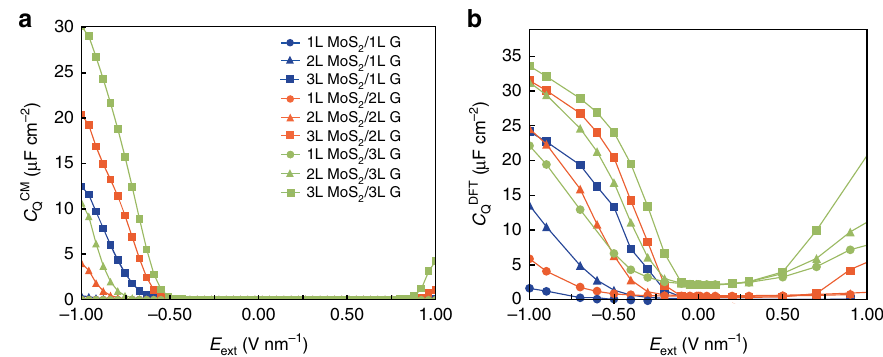
Fig. 7 Quantum capacitance C Q for different MoS 2 /Graphene heterostructures. a – b Quantum capacitances calculated from the classical model C Q CM ( μ F cm − 2 ) and from the DOS pro fi le of ab initio calculations C Q DFT ( μ F cm − 2 ) as a function of the external fi eld E ext (V nm − 1 ) for various MoS 2 /Graphene vdWHs, respectively. The quantum capacitance increase more under negative electric fi eld than positive fi eld. Both classical and DFT calculations show similar trends of relationship between layer numbers and quantum capacitance: the layer numbers of MoS 2 contributes more to the total quantum capacitance than graphene under strong electric fi eld, consistent with the fi ndings of layer-dependent dipole moment and